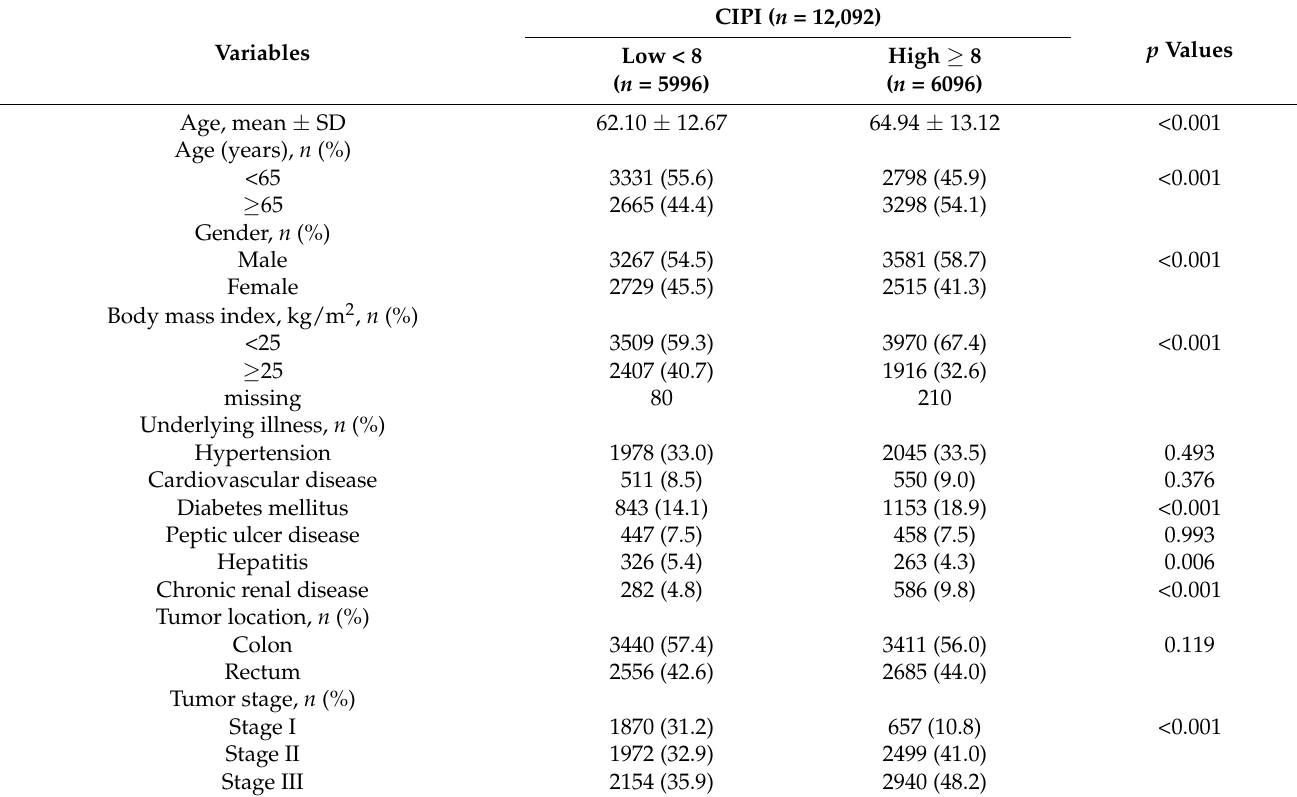
Table 1. Demographic characteristics of patients based on the CIPI.